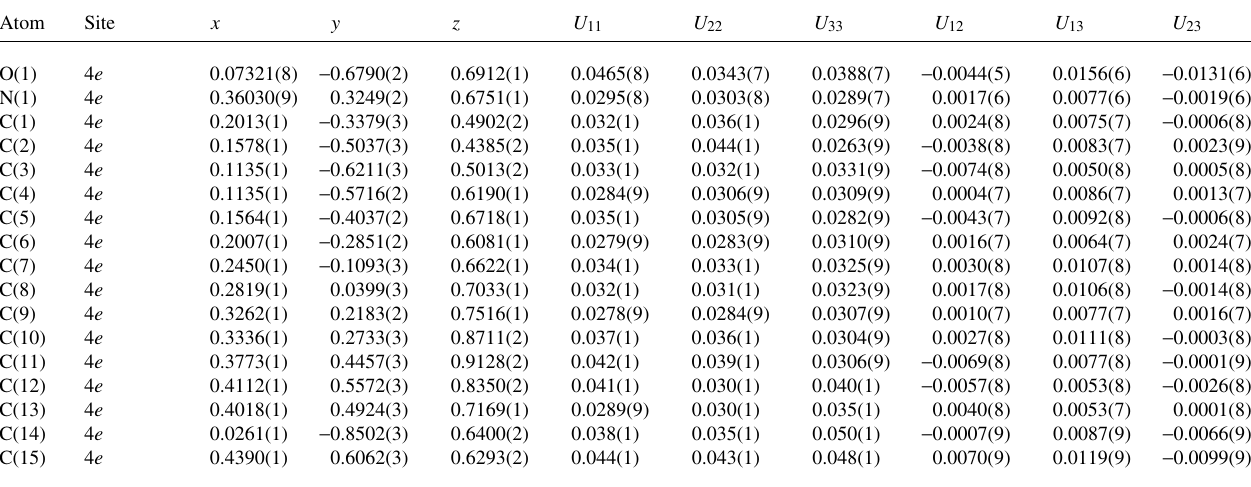
Table 3. Atomic coordinates and displacement parameters (in Å 2 ) .